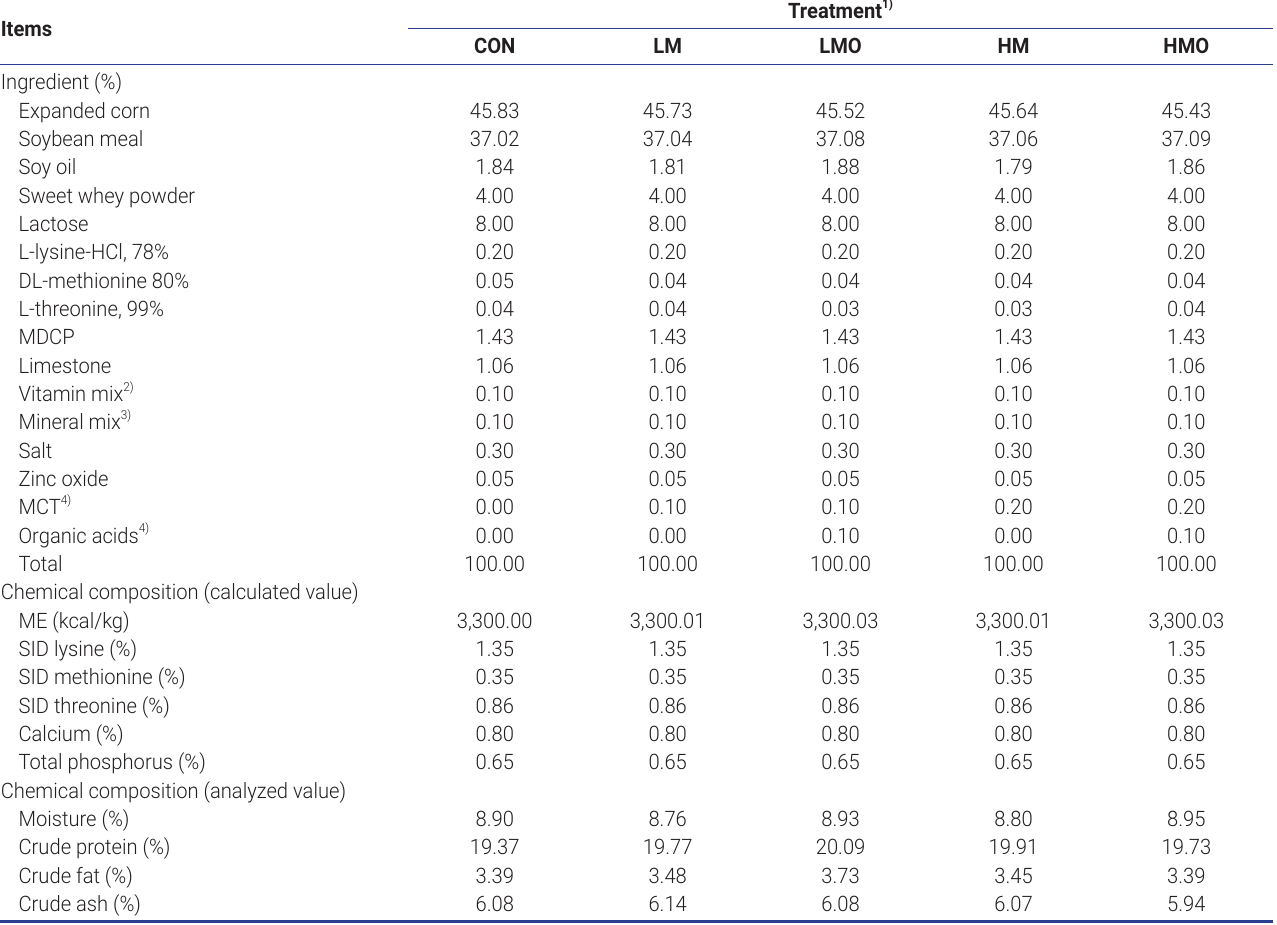
Table 1. Formula and chemical compositions of the experimental diets during the weaning phase 1 (0 to 2 wk)